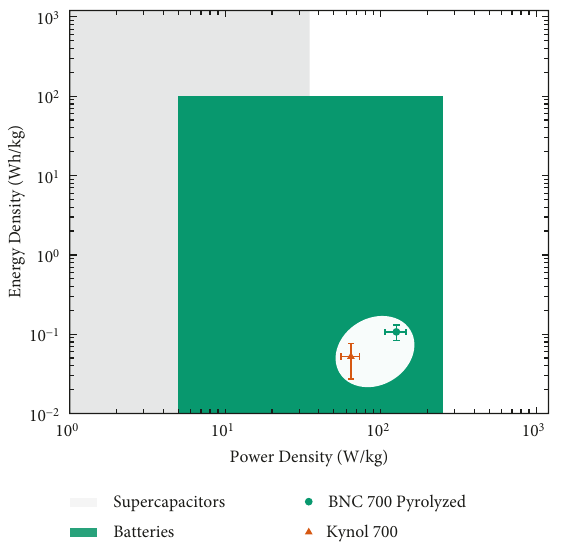
Figure 12: Ragone plot relating energy density with power density. The hatched green area corresponds to the usual battery limit and the hatched purple to supercapacitors. The error bars represent the standard deviation of measurements for four runs on each sample ( n �